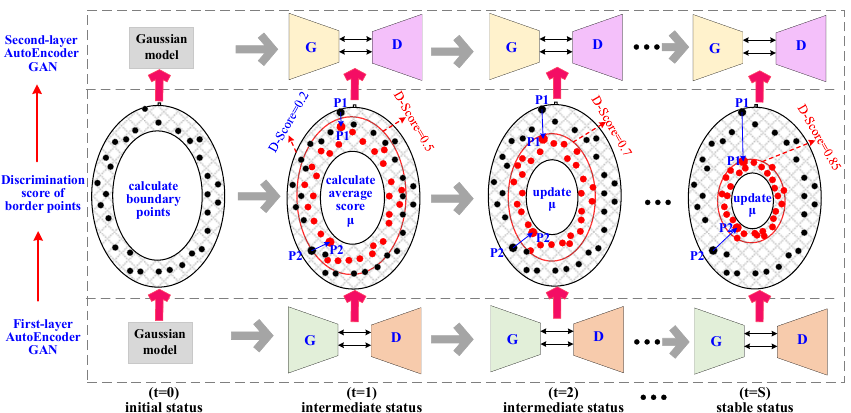
Figure 5. Discriminator score-based marginal distribution learning.